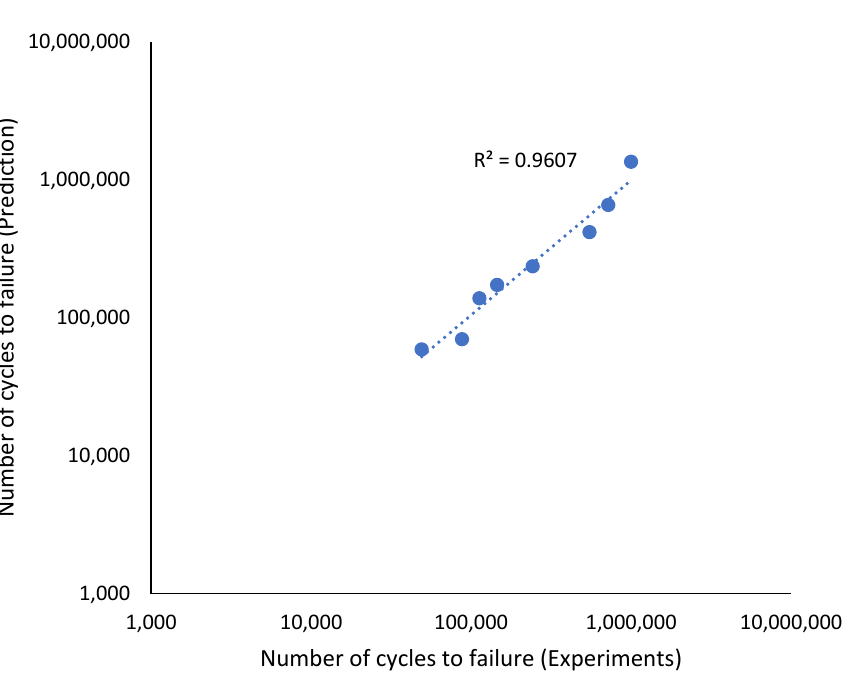
Figure 18. Relationship between the modified fatigue life model of the Basquin equation and experiments fatigue life.